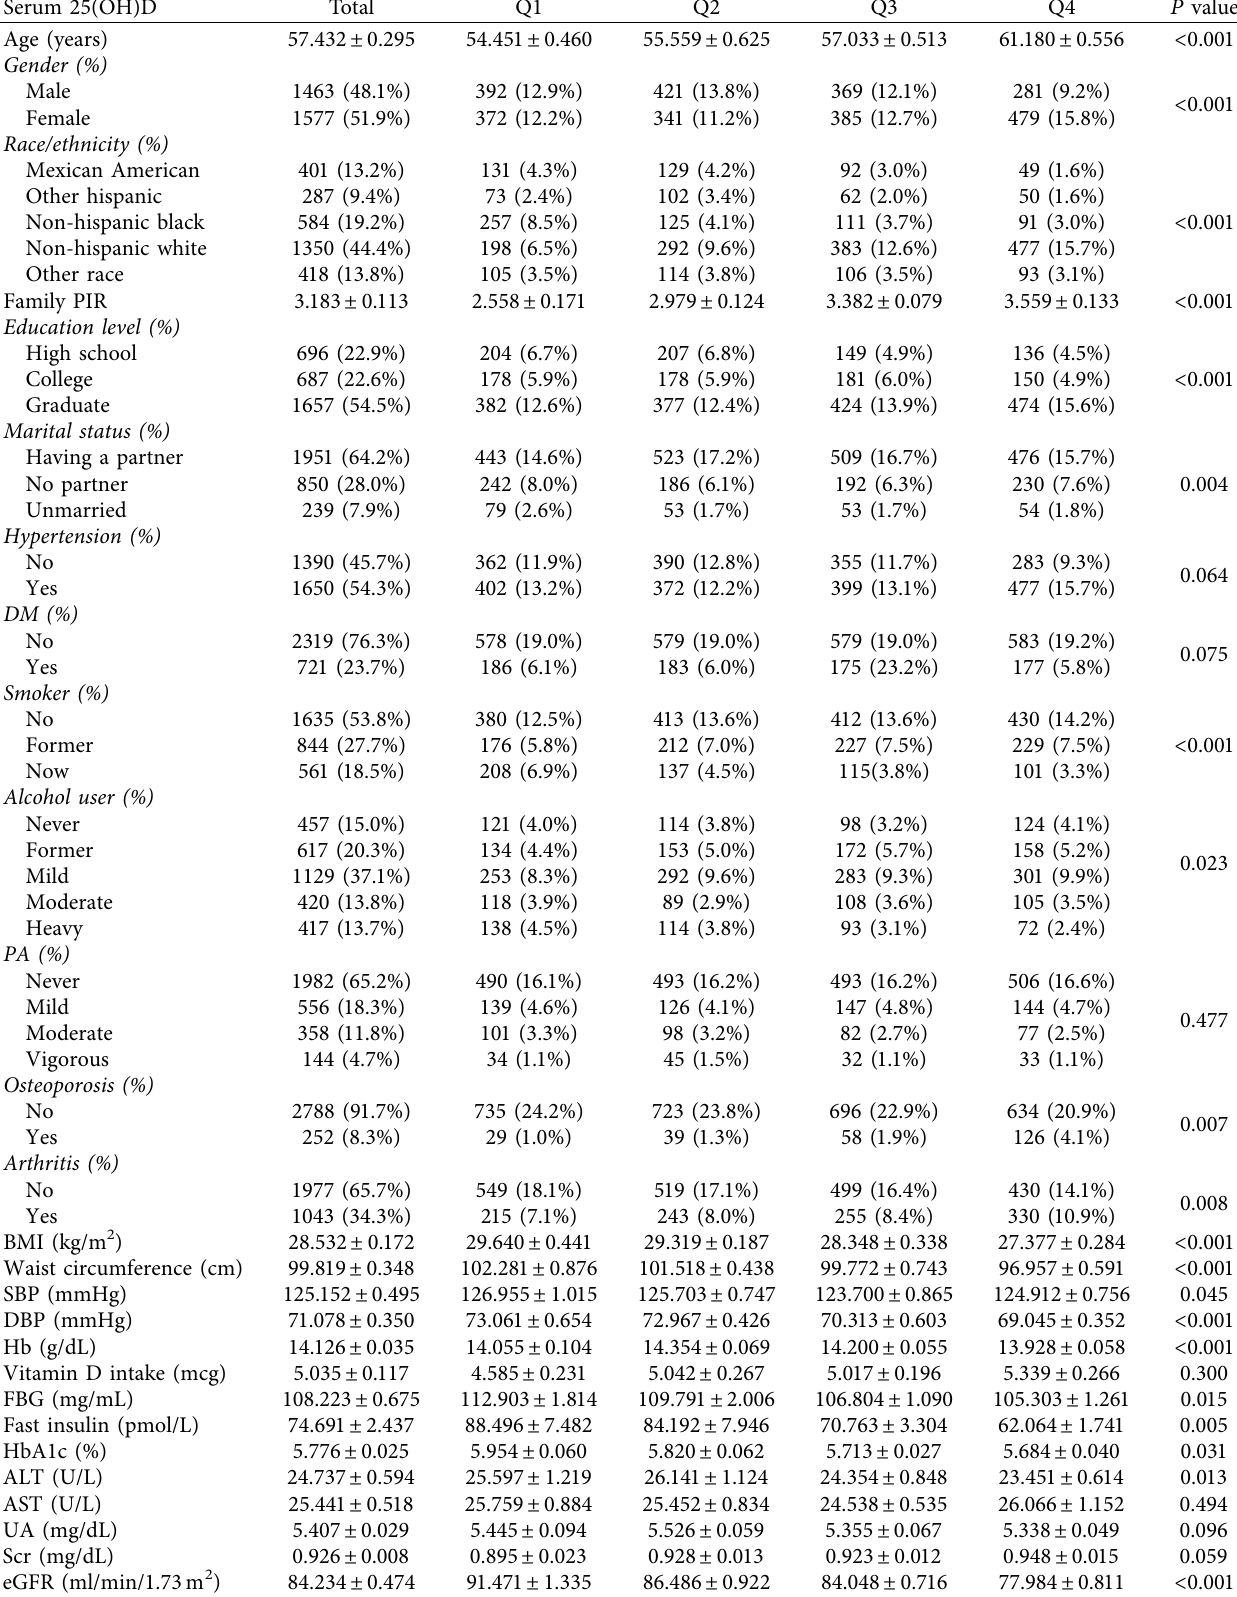
Table 1: Characteristics of the study population based on serum 25-hydroxyvitamin D (25(OH)D)